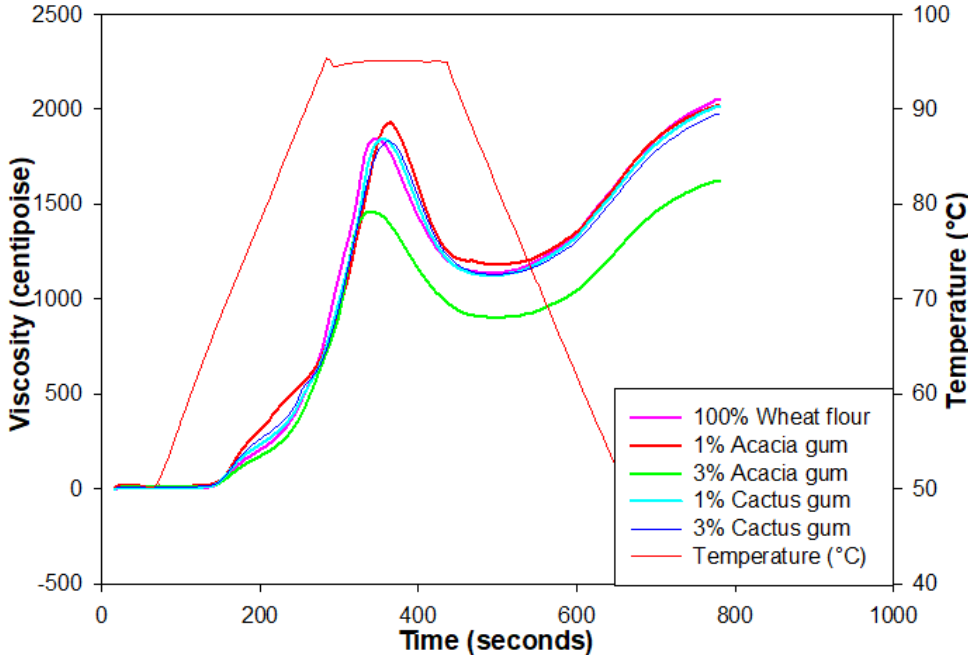
Figure 1. RVA profiles of wheat flour blends with acacia and cactus gums.